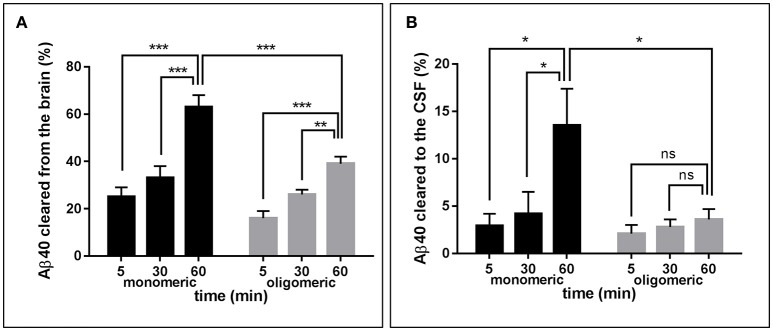
Brain clearance of radiolabeled Aβ species. (A) Clearance of monomeric (black bars) and oligomeric (gray bars) [125I]Aβ1-40 species removed from the brain at three different time-points. (B) Monomeric (black bars) and oligomeric (gray bars) [125I]Aβ1-40 species cleared to the CSF evaluated at three different time-points. In all cases bars illustrate percentage cleared relative to total injected radioactivity; values represent mean ± SD obtained from inoculation of 5–7 mice (ANOVA and Tukey post-hoc test; ns, not significant; *p < 0.05; **p < 0.01; ***p < 0.001).